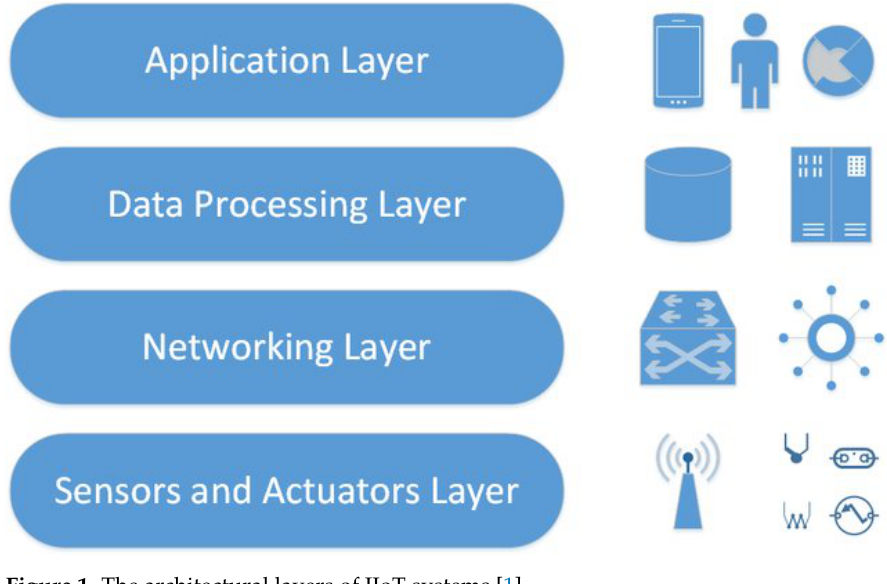
Figure 1. The architectural layers of IIoT systems [1].